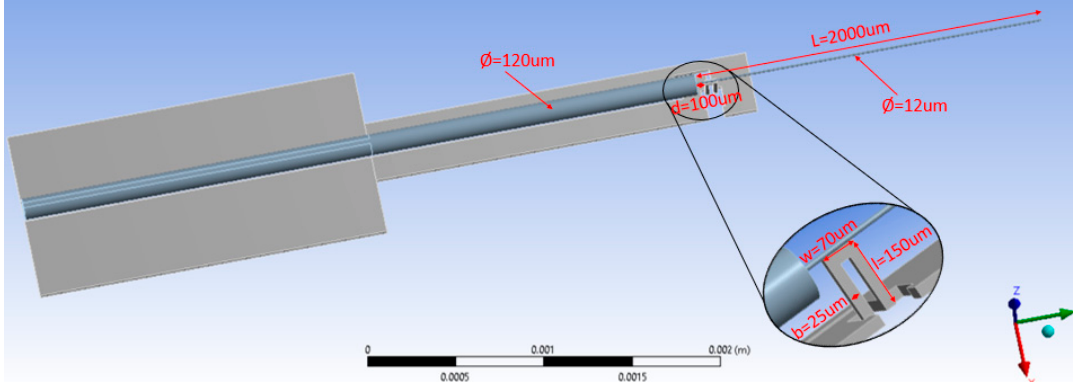
Figure 5. Dimensions of the device being simulated using ANSYS.